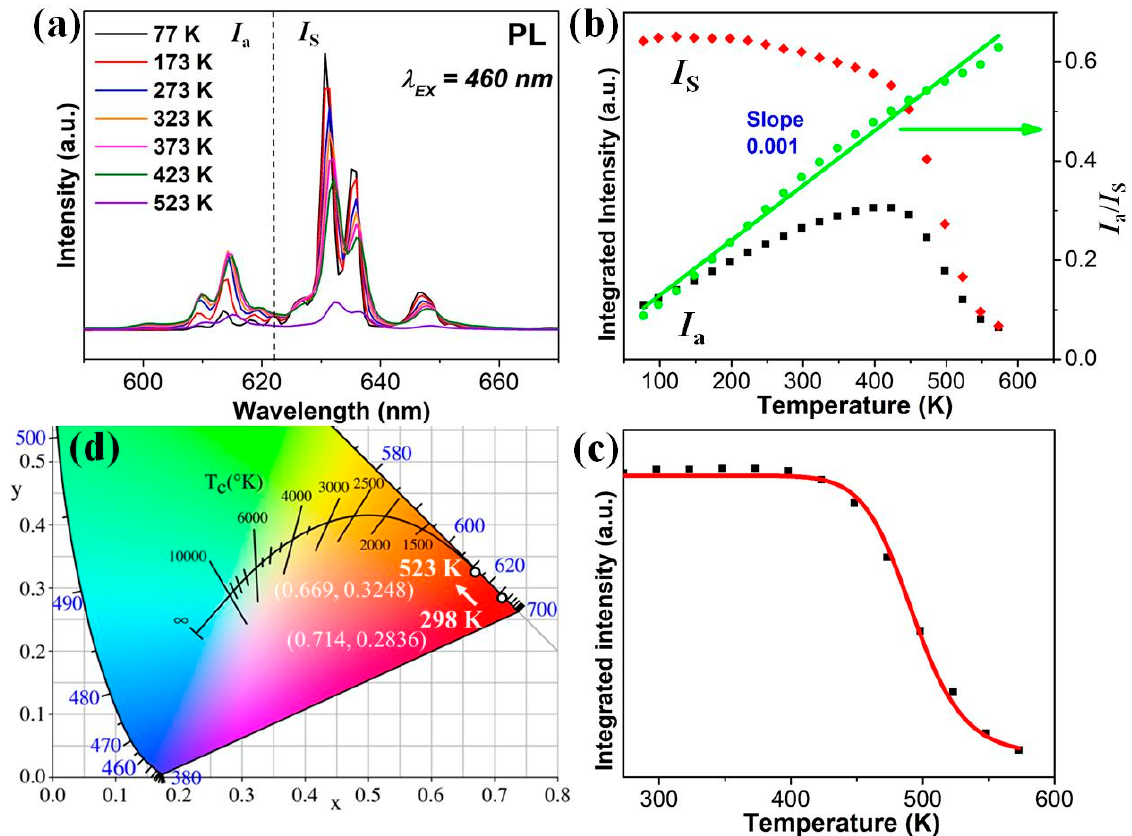
Figure 5. ( a ) Temperature-dependent PL spectra of the KTFM nanosheets in the range of 77 K–523K. ( b )The integrated intensity of anti-Stokes and Stokes emission lines. ( c ) The relative red PL intensity as a function of temperature (273 K–573 K). The solid line represents the fitting result with the expression I T / I 0 = [1 + D exp( − E a /k B T)] − 1 . ( d ) CIE chromaticity coordinates (x, y) shift from 298 K to 523 K of KTFM nanosheets.